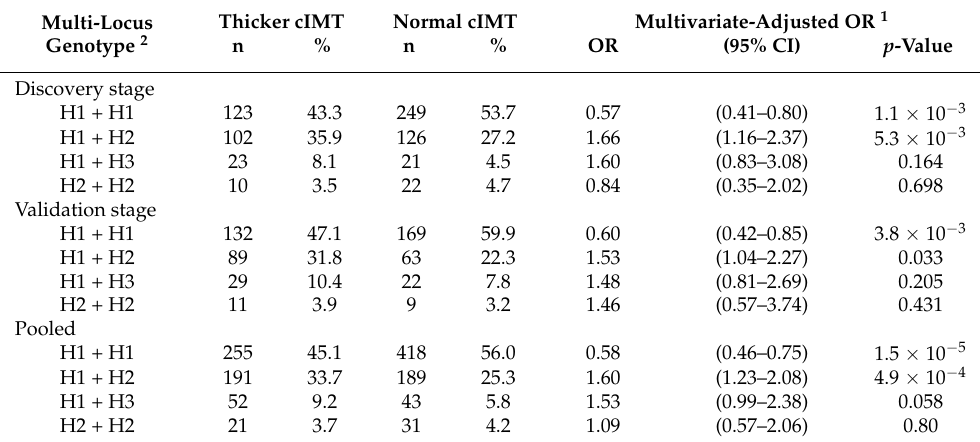
Table 3. Association analyses for multi-locus genotypes with thicker carotid IMT. Thicker cIMT Normal Multi-Locus Genotype 2